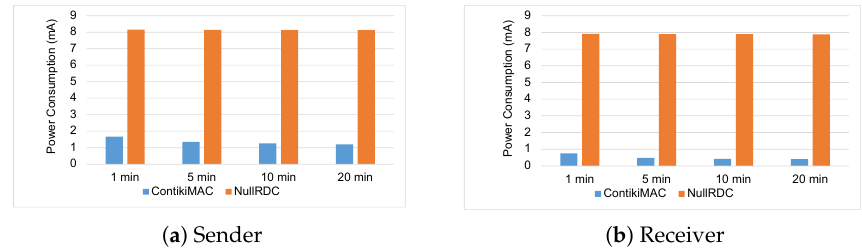
Figure 12. Power consumption of the sensor node based on second scenario.